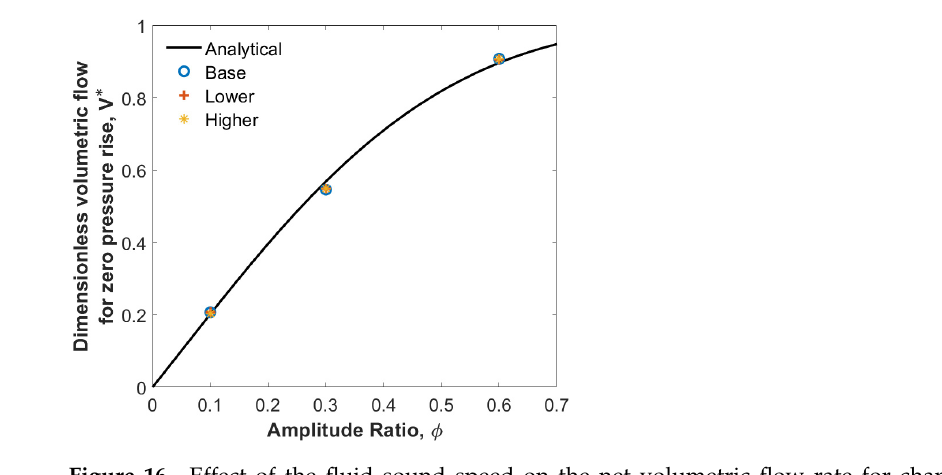
Figure 16. Effect of the fluid sound speed on the net volumetric flow rate for changes in the sound speed.